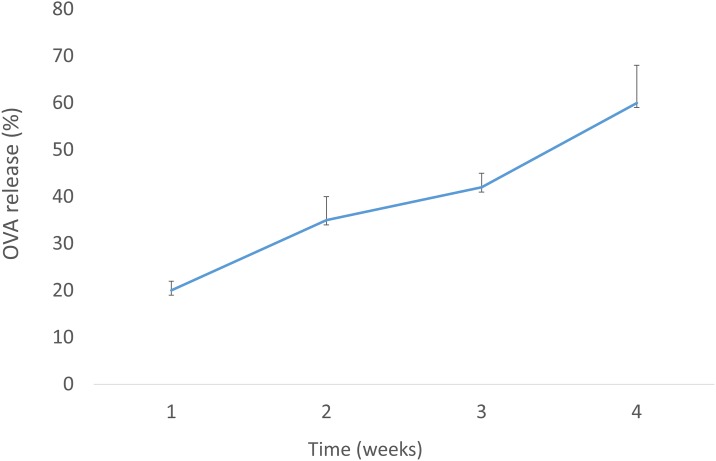
In vitro release profile of OVA from PLGA NPs.One milligram of the PLGA/OVA/MPLA NPs were dispersed in 4 ml of PBS containing 0.02% sodium azide, and then were kept at 37°C. At the indicated weeks, the supernatants were collected after centrifugation and the protein contents were analyzed.